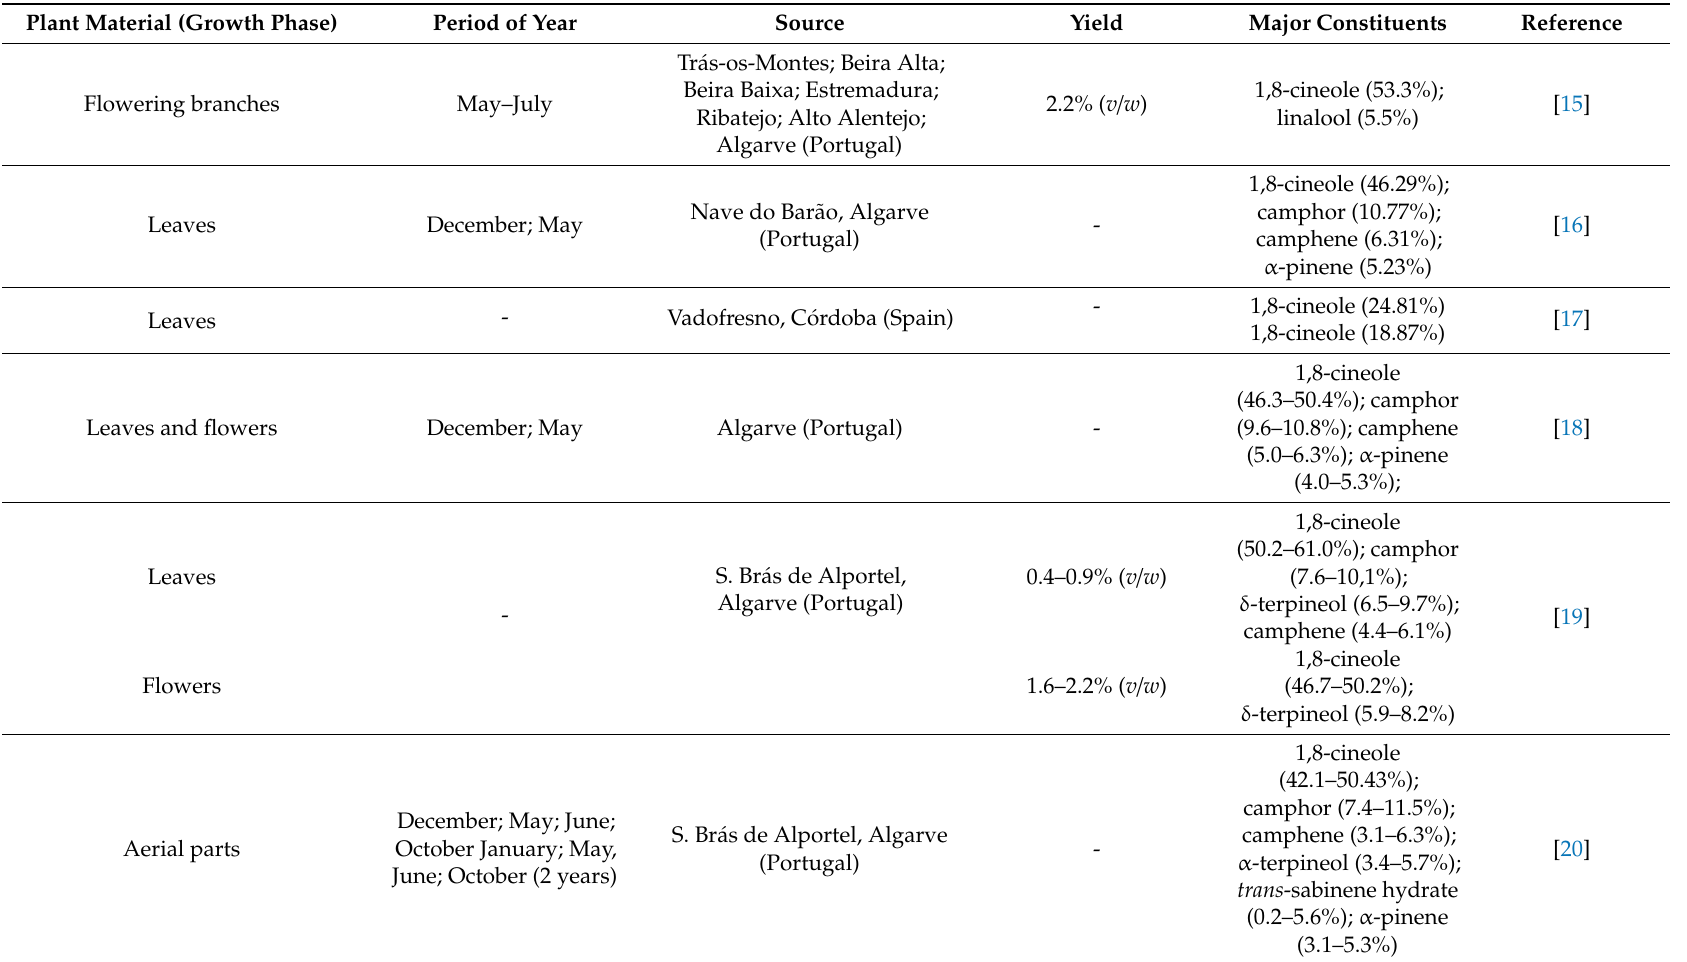
Table 1. Obtention features and characterization of the Thymus mastichina essential oil and its main constituents (equal or higher than 5%). Plant Material (Growth